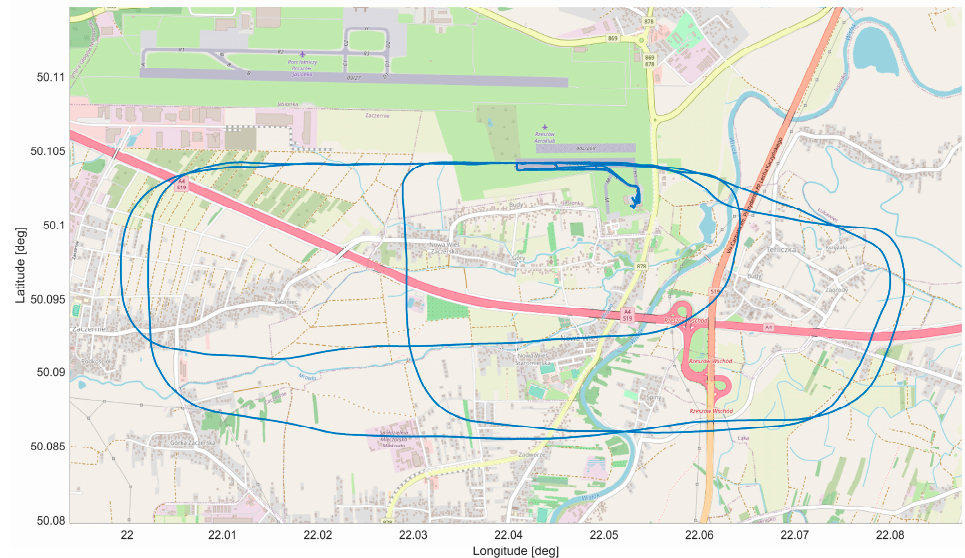
Figure 6. View of the research flight